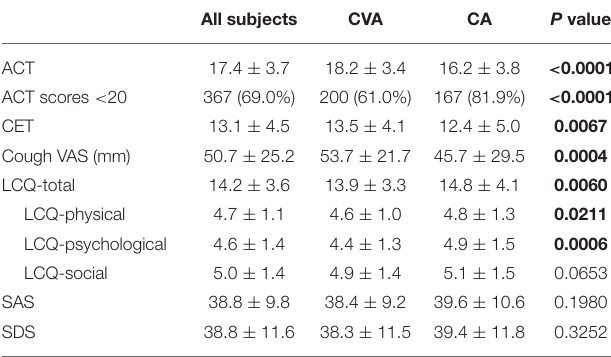
TABLE 3 | Questionnaire assessment.